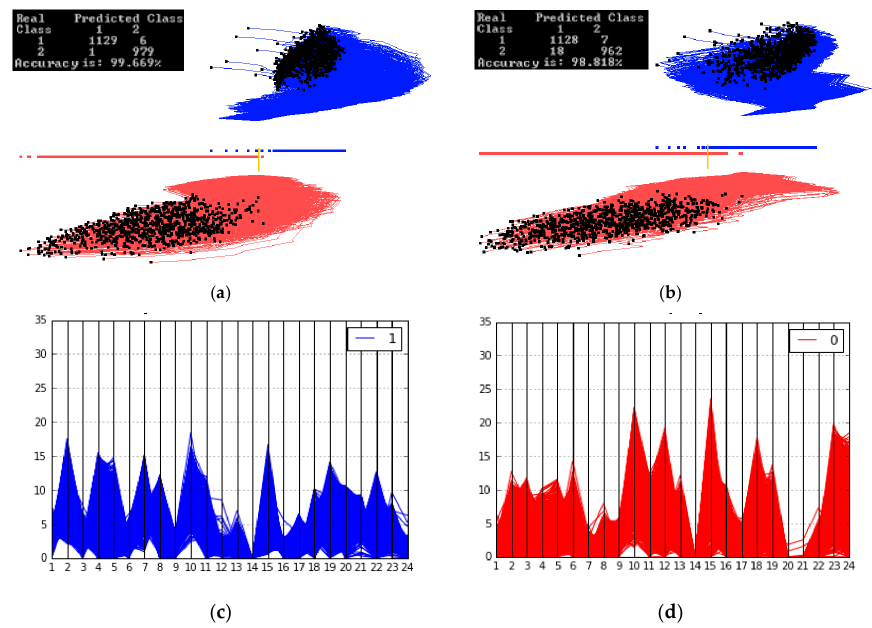
Figure 18. Comparing encoded digit 0 and digit 1 on the parallel coordinates and GLC-L, using 24 dimensions found by the Autoencoder among 484 dimensions. Each vertical line is one of the 24 features scaled in the [0,35] interval. ( a ) Results for the best linear discriminant function of the first run of 20 epochs; ( b ) Another run of 20 epochs, best linear discriminant function from this run. Accuracy drops 1%; ( c ) Digit 1 is visualized on the parallel coordinates; ( d ) Digit 0 is visualized on the parallel coordinates